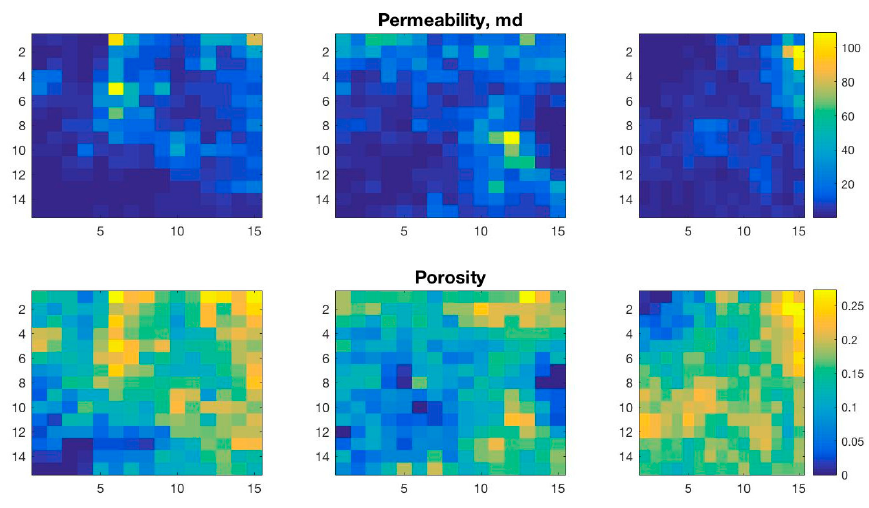
Figure 3. Permeability and porosity of single-phase reservoir model.